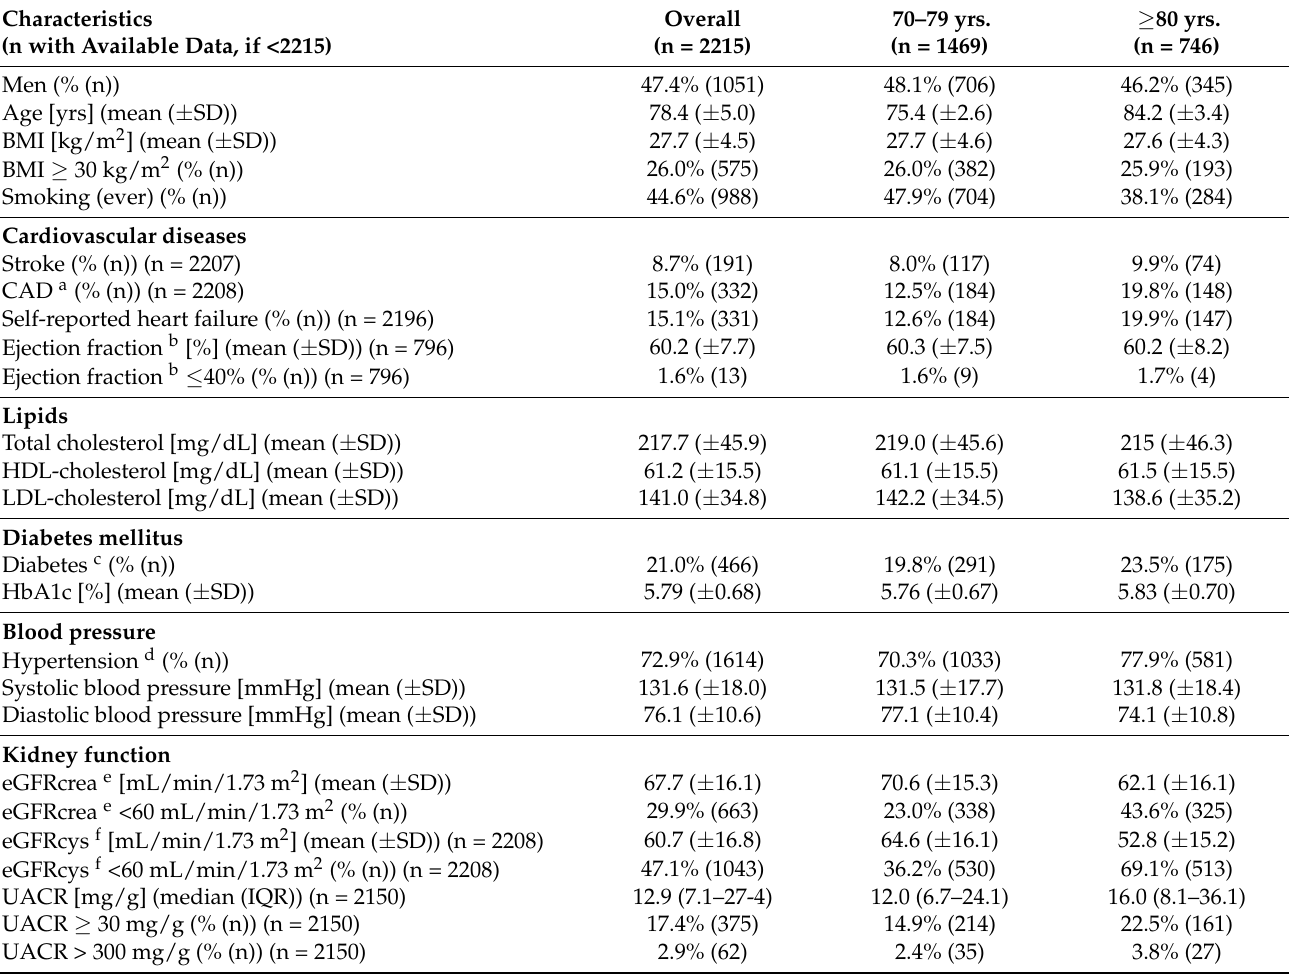
CAD = coronary artery disease; eGFRcrea, eGFRcys = estimated glomerular filtration rate calculated from serum creatinine or serum cystatin C, respectively; UACR = urine albumin–creatinine ratio; ( a ) self-reported history of myocardial infarction, bypass surgery, and/or stent implantation; ( b ) measured in four-chamber view using Simpson ´ s method [35,36]; ( c ) self-reported diabetes and/or antidiabetic treatment [32]; ( d ) measured blood pressure ≥ 140/90 mmHg or (antihypertensive treatment and positive self-report) [29]; ( e ) via